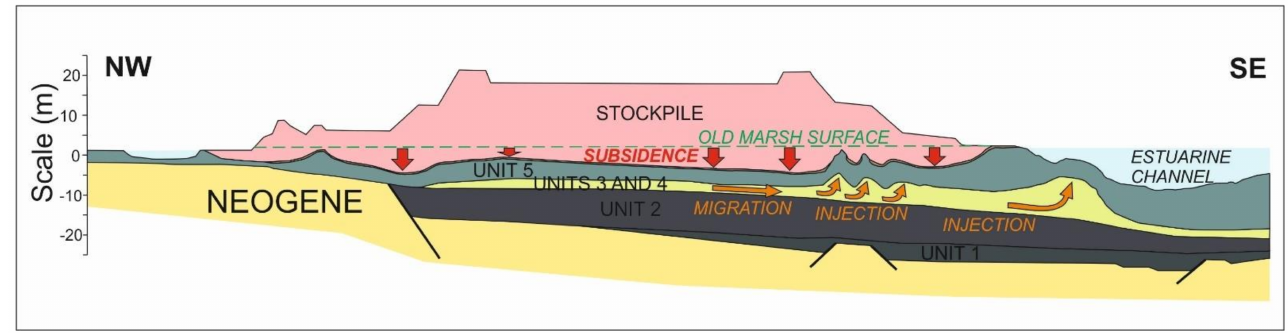
Figure 10. Geologic profile produced using the drilling core information from [15]. This diagram represents the conceptual model of overpressure processes: subsidence, fluidized sediment migration, and